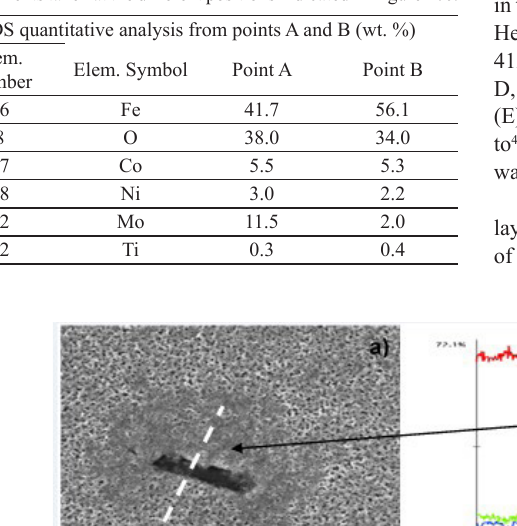
show the Raman spectrum obtained from the oxide layer growth under Air/Steam/N on both alloys, respectively.